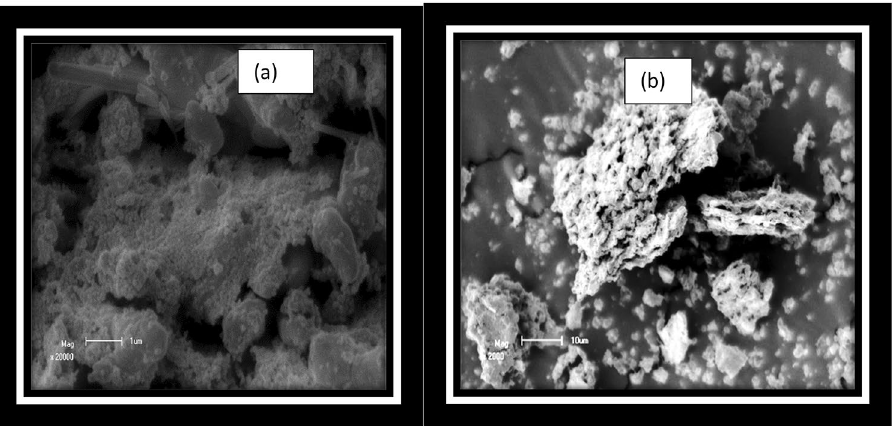
Figure 7. Scanning electron microscope (SEM) FeS thin films deposited as nanocrystalline FeS from banana leaf extraction and pure FeS thin films ( a , b ),